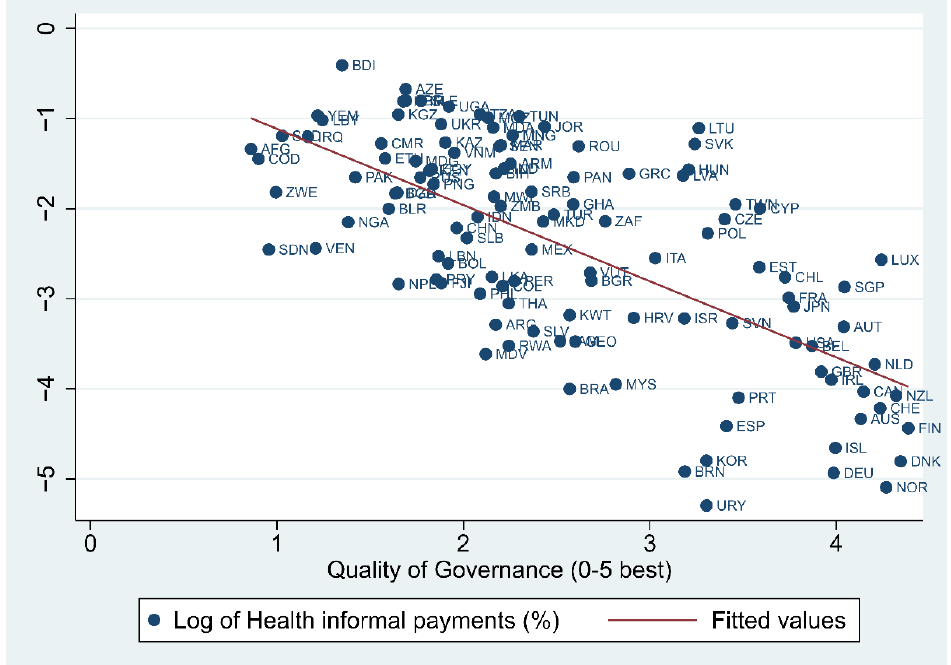
Figure 2. The relation between informal payments in health and the quality of governance. Note: Average values over the 2009–2013 period. Source: Authors’ representation using data from Trans- parency International and the World Bank.